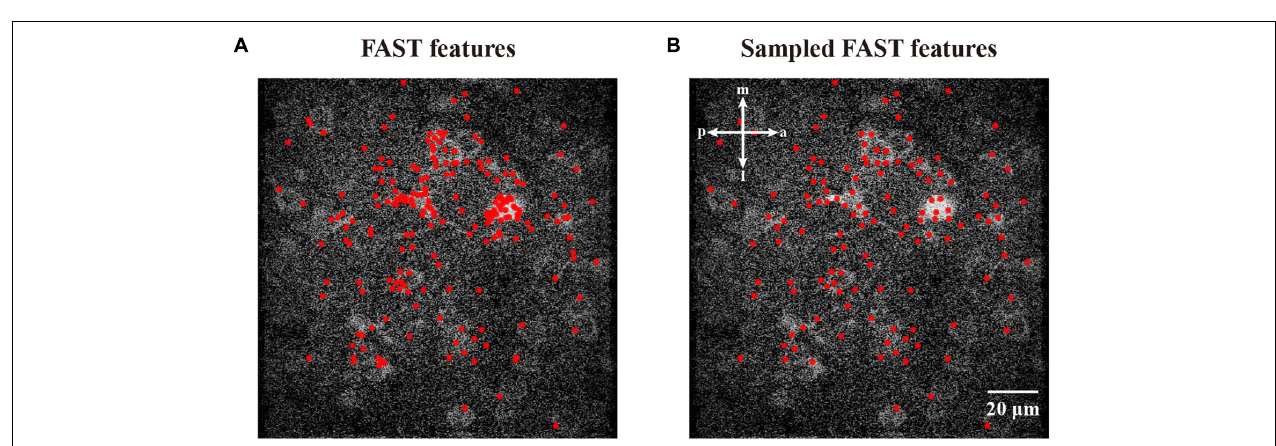
FIGURE 1 | Processing pipeline for two-photon Ca 2 + imaging data. (A) Flowchart of the proposed motion correction method. The red marked modules are the key steps in the processing flowchart. (B) Illustration of the feature (red dots) extraction for the imaging data. (C) Illustration of the feature update for a raw frame. The features of the current frame and the next frame are marked as the red and blue dots, respectively. (D) Illustration of matching features between template image and raw frame. The anatomical direction: a, anterior; m, medial; p, posterior; l, lateral.